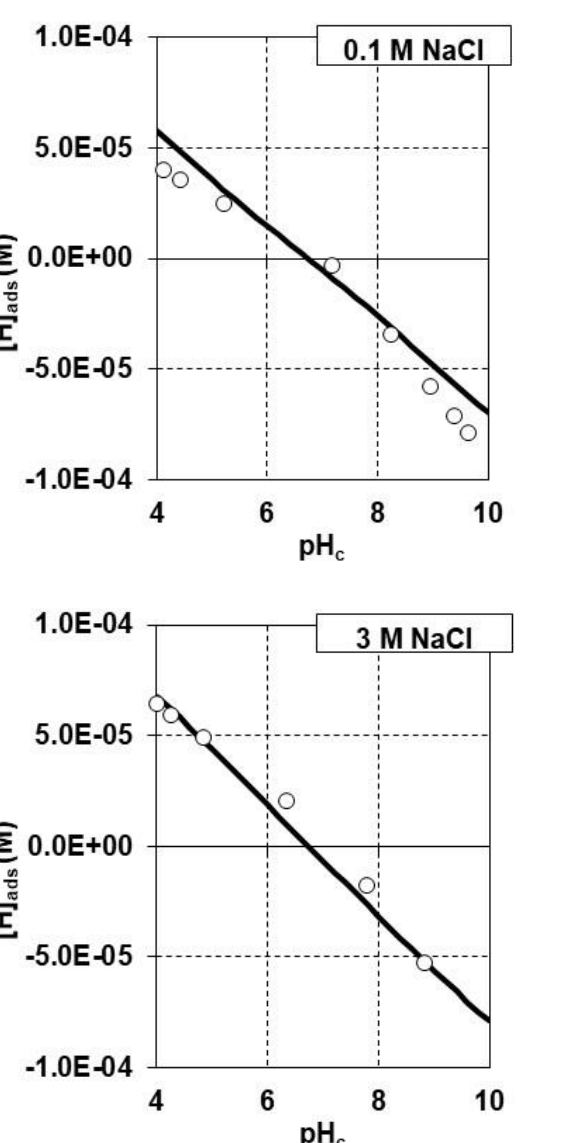
Figure 5. H + adsorption (H ads ) as a function of pH c for the Fe(III) oxide particles at different ionic strengths (0.1–5 M) in NaCl medium. Symbols denote the experimental results, while lines represent the best fit model using parameters from Table 1 and Pitzer activity coefficients for aqueous solution speciation. Conditions for the titrations are given in the experimental section of the main text.